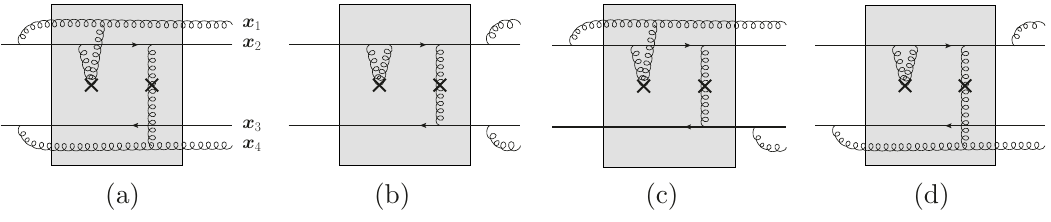
Figure 3 . Contributions to the cross section for q +A and (c,d) ‘interference’ contributions (in the convention where the lower half of a diagram represents a conjugate